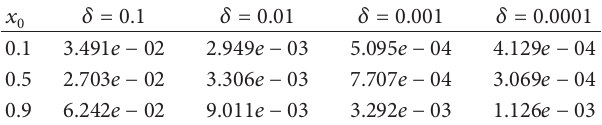
Table 3: The resulted values of RES (𝑝) using MFSRBF for various levels of noise 𝛿 , different values of 𝑥 0 , and 𝑇 = 4.1 .